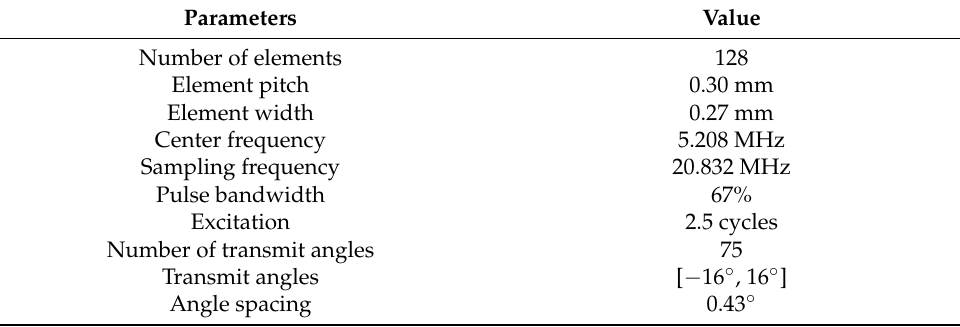
Table 1. Parameter settings of acquisition system for simulation and